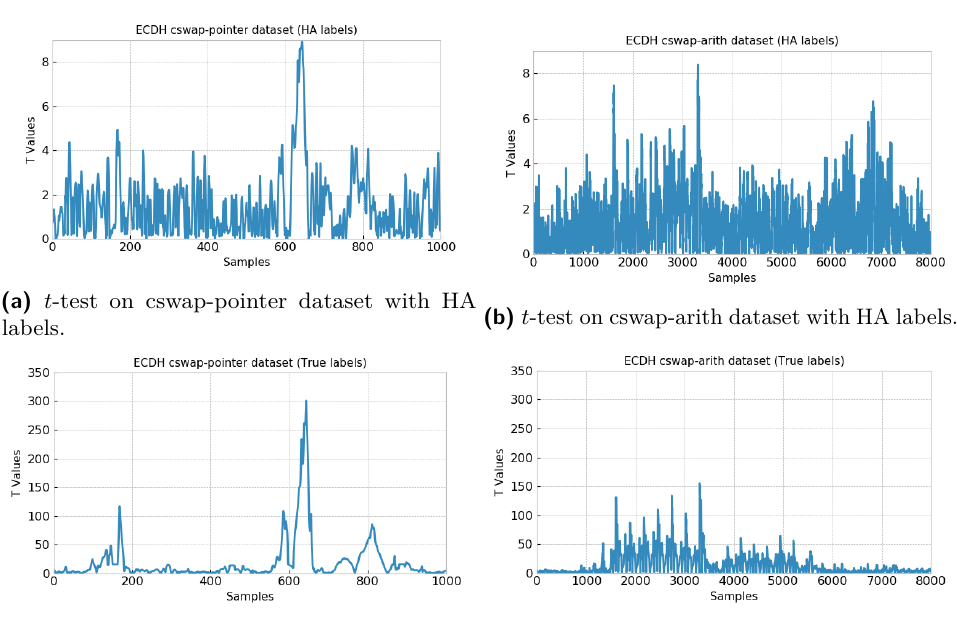
Figure 6: t -test on the two considered